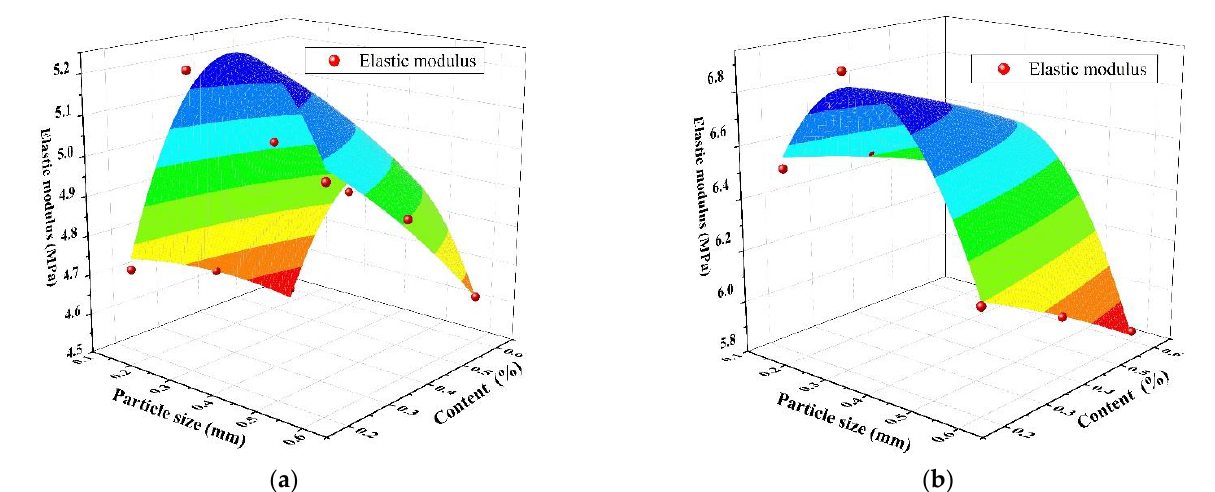
Figure 8. The relationship between SAP particle size, content, and elastic modulus: ( a ) water–cement ratio of 0.3; ( b ) water–